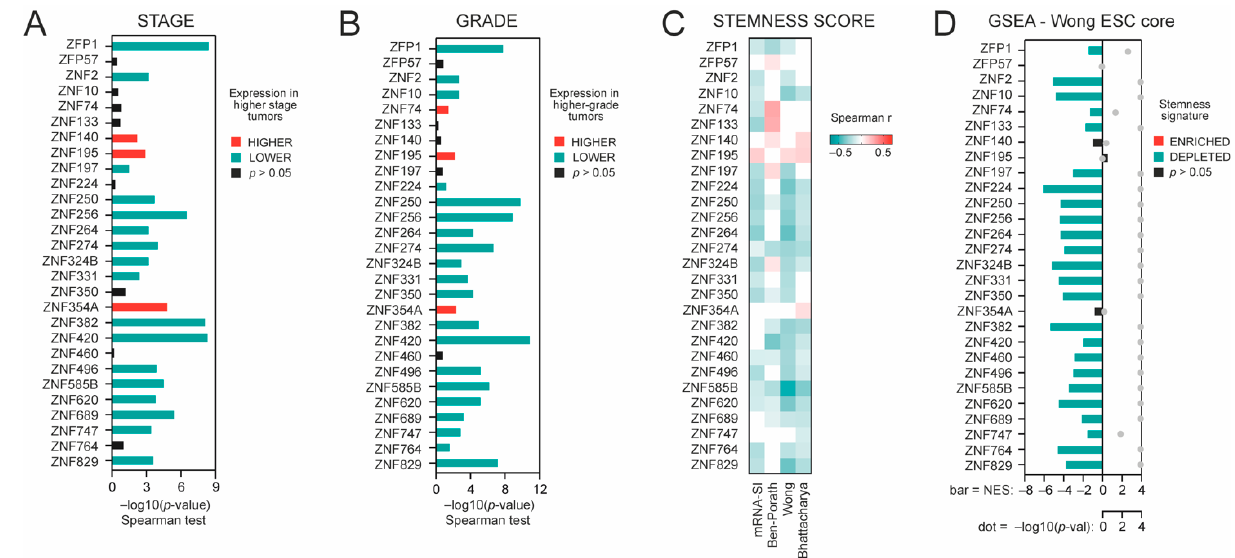
Figure 2. The association between KRAB-ZNF expression and tumor dedifferentiation status. ( A ) The association between KRAB-ZNF expression and tumor stage—either lower (green) or higher stage (red), as determined with Spearman correlation test ( − log10( p -value)). ( B ) The association between KRAB-ZNF expression and tumor grade—either lower (green) or higher grade (red), as determined with Spearman correlation test ( − log10( p -value)). ( C ) The heatmap of Spearman’s correlation between KRAB-ZNFs’ expression and four distinct stemness indices (mRNA-SI, Ben-Porath signature, Wong signature, Bhattacharya signature). Red and green denote positive and negative correlation, respectively. Only statistically significant associations are shown ( p < 0.05). ( D ) The Gene Set Enrichment Analysis (GSEA) using genes significantly correlated (FDR < 0.01) with KRAB-ZNF level in KIRC patients was performed with the stemness signature (Wong_ESC_Core) as a reference. Bar—the normalized enrichment score (NES). Grey dot—statistical significance ( − log10FDR).